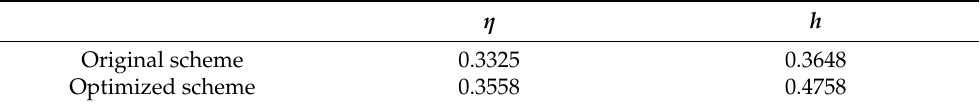
Table 2. Comparison of design parameters between original scheme and optimized scheme. Table 3. Comparison of optimization objectives between the original scheme and optimized